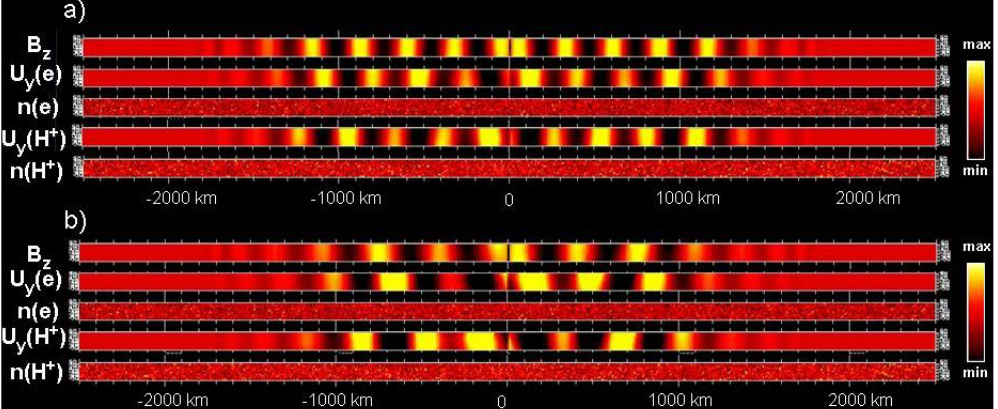
Fig. 4. Plane wave runs in the HYB-em model: Plasma parameters. In panel (a) the initial electron density in the simulation box was ∼ 0.016cm − 3 and in panel (b) it was ∼ 0.021cm − 3 . The axes are as in Fig. 3: The horizontal axis is the x-axis from − 2500km to +2500km, and the vertical axis from − 50km to +50km. The values are created at the y =0 plane. The oscillating plane source is positioned at x =0 and its frequency is 1.5kHz. The values correspond to the situation at t =6.64ms. In panel (a) the tables from top to bottom are: B z from − 1 × 10 − 12 T to 1 × 10 − 12 T, the velocity of electrons in the y-direction ( U y (e) ) from − 10km/s to 10km/s, the electron density ( n(e) ) from 0 to 0.03cm − 3 , the velocity of protons in the y-direction ( U y (H + )) from − 5m/s to 5m/s and the proton density ( n (H + )) from 0 to 0.03cm − 3 . In panel (c) the initial electron density was increased to 0.021cm − 3 . Tables from top to bottom are: B z from − 1 × 10 − 12 T to 1 × 10 − 12 T, U y (e) from − 10km/s to 10km/s, n(e) from 0 to 0.04cm − 3 , U y (H + ) from − 5m/s to 5m/s and n (H + ) from 0 to 0.04cm − 3 . In both panels the color map on the right hand side is a linear color map from the minimum value (min) of the variable to the maximum value (max) of the